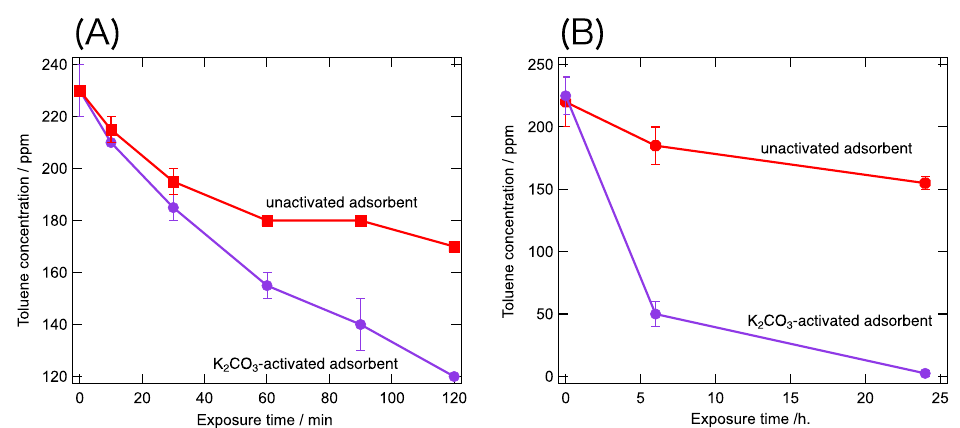
Figure 6. Toluene concentration as a function of time during ( A ) 120 min and ( B ) 24 h of observation for unactivated adsorbent (red) and K 2 CO 3 -activated adsorbent (purple).